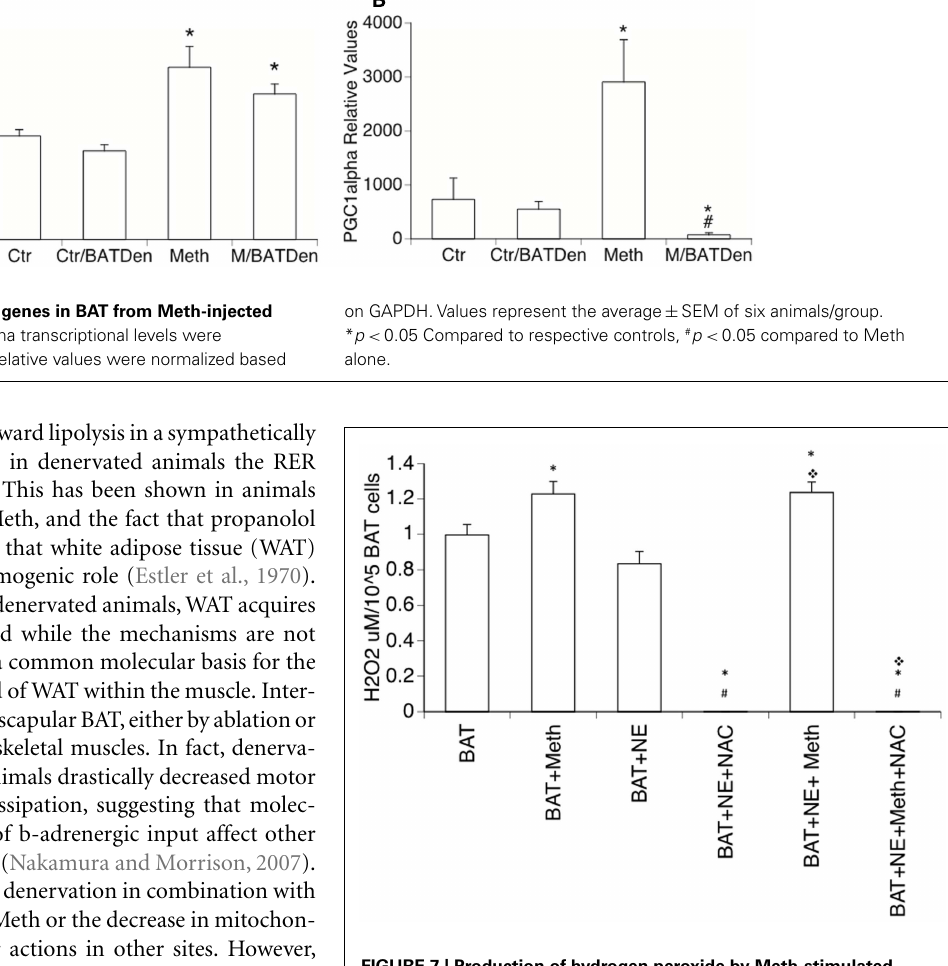
FIGURE 7 | Production of hydrogen peroxide by Meth-stimulated mature brown adipocytes. Single cell suspensions of BAT were obtained from adult mice and placed in culture, and were immediately stimulated with 60 µ M of Meth, 1ng/ml of Norepinephrine (NE), 5 µ M of N -acetyl-d-cysteine (NAC), or combinations of these reagents. Hydrogen peroxide was detected in the cultures for 60min. Results correspond to the average of four independent readings. * p < 0.05 Compared to respective controls, # p < 0.05 compared to Meth